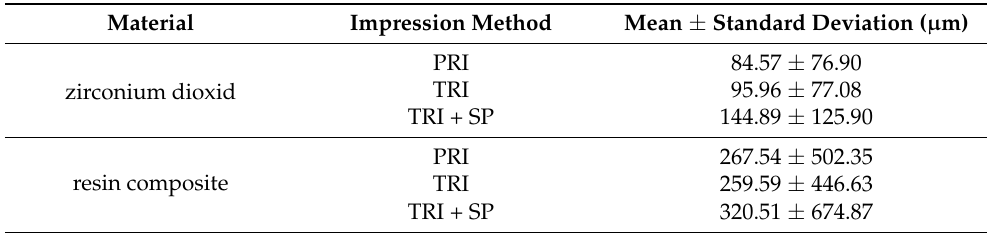
Table 3. Descriptive statistics of linear discrepancies ( µ m) for fabricated CAD/CAM-P+C milled of zirconium dioxid and resin composite based on digital impressions with IOS (PRI = Primescan, TRI = Trios 4, and TRI + SP = Trios 4 and